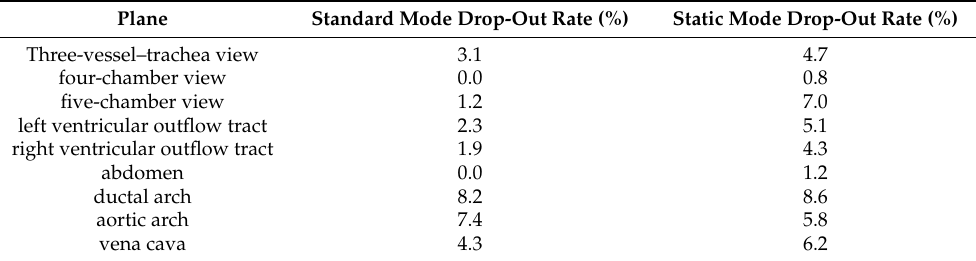
Table 2. Drop-out rates for each plane.